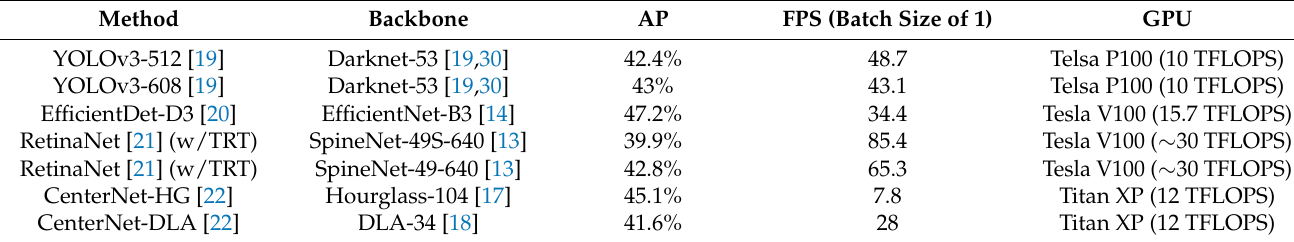
Table 1. Comparison between different SSD